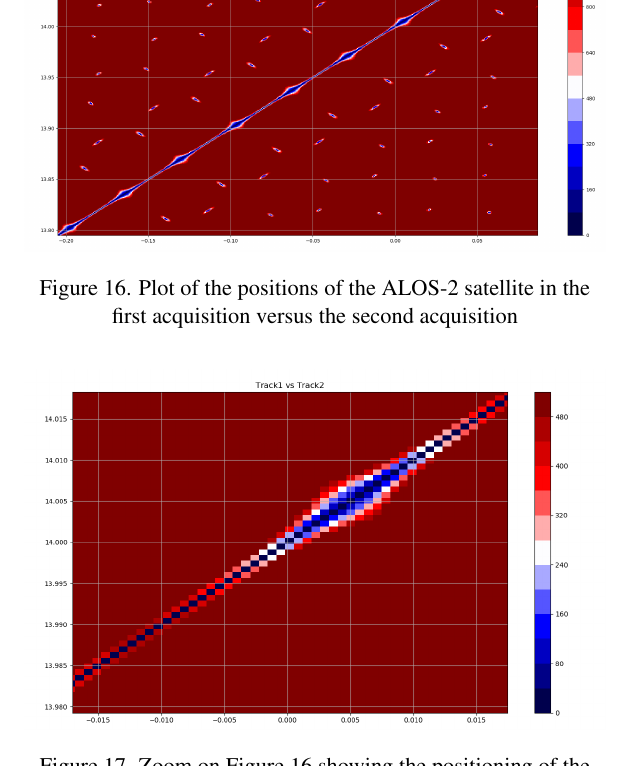
Figure 17. Zoom on Figure 16 showing the positioning of the ALOS-2 satellite during data acquisition in the area of